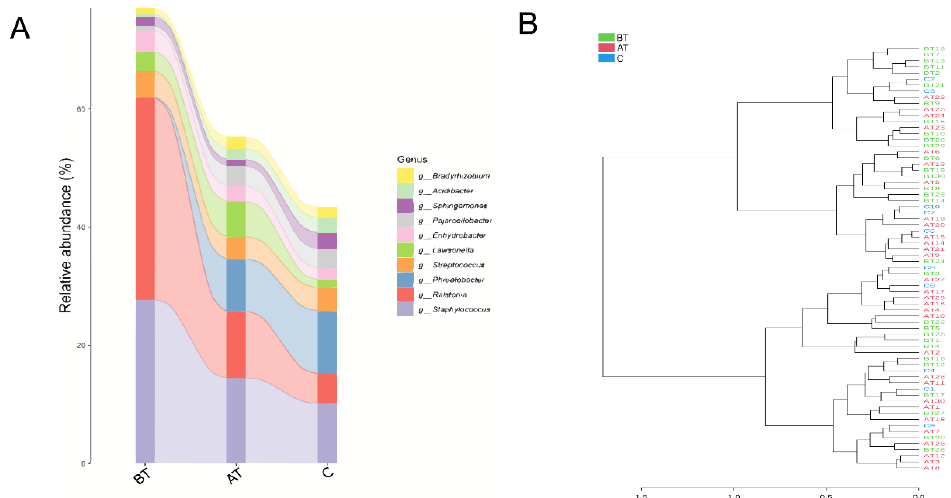
Figure 6. Difference between facial microbiota of the pre-treated (BT), treated (AT), and control (C) acne groups. ( A ): Sankey chart presenting the pattern of change in facial microbiota among the three experimental groups at the genus level. ( B ): Sample-wise similarity-based dendrogram of the three experimental groups.